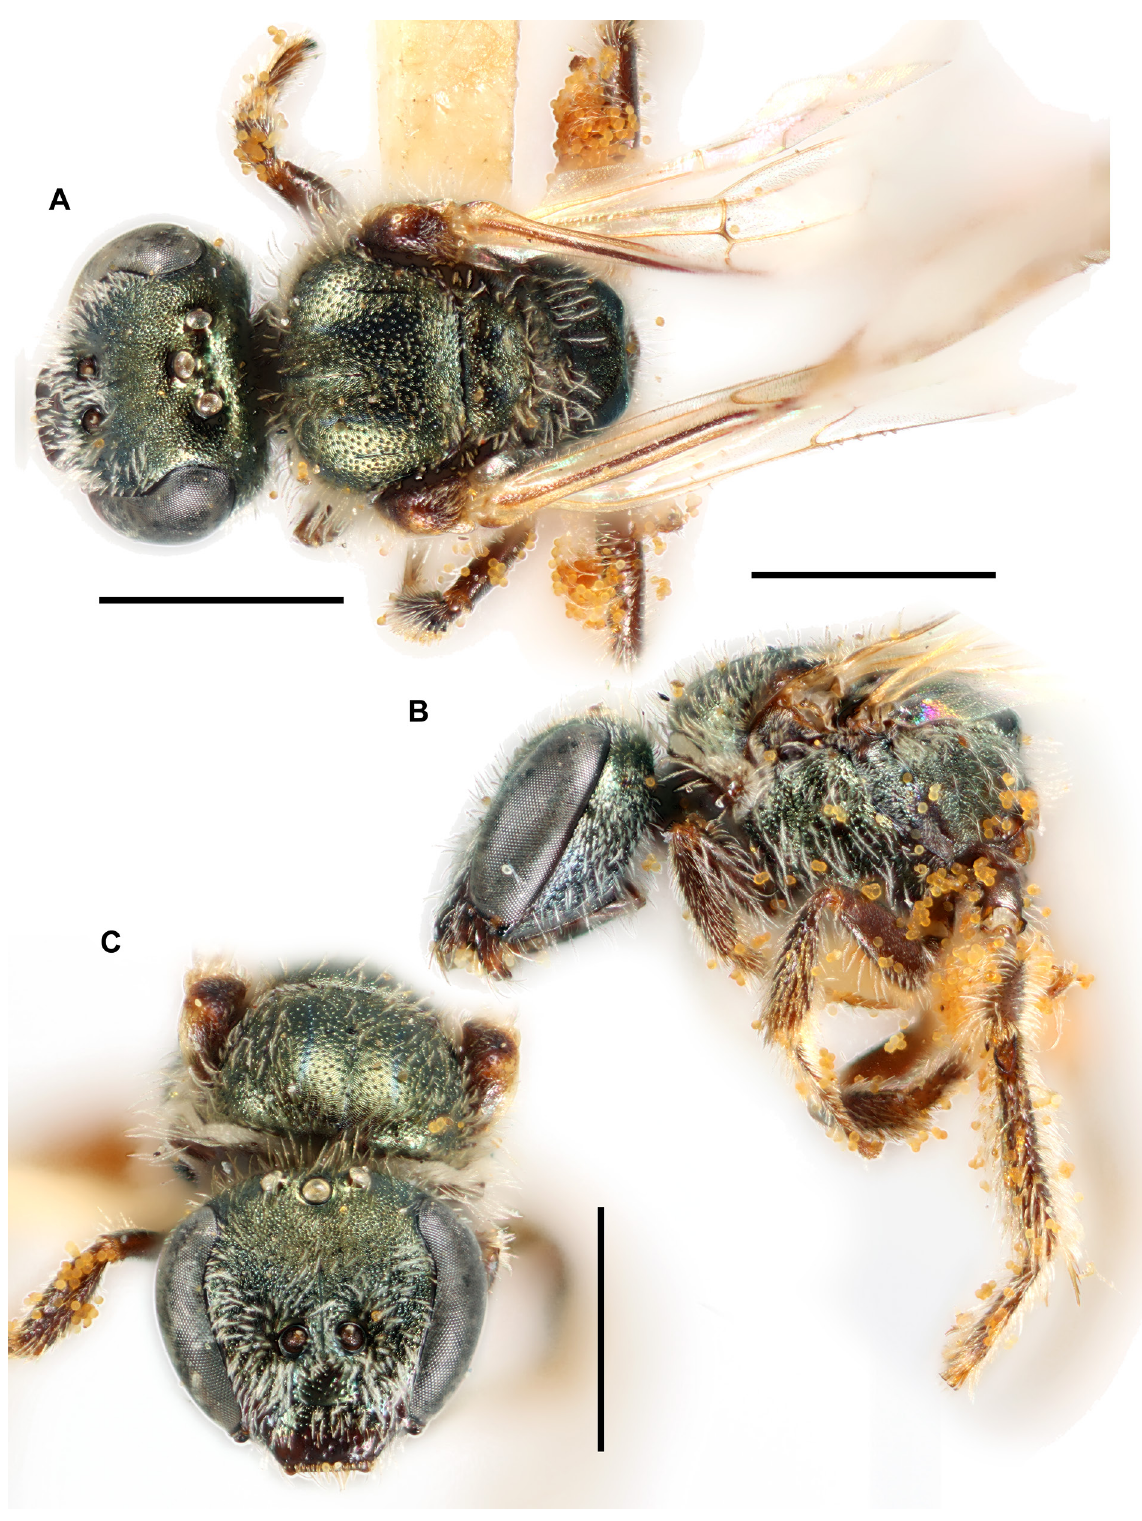
Fig. 60. Lasioglossum ( D .) stictaspis (Sandhouse, 1923), ♀, holotype of L . ( D .) albuquerquense Michener, 1937 (CAS). A . Dorsal habitus. B . Lateral habitus. C . Face. Scale bars = 1